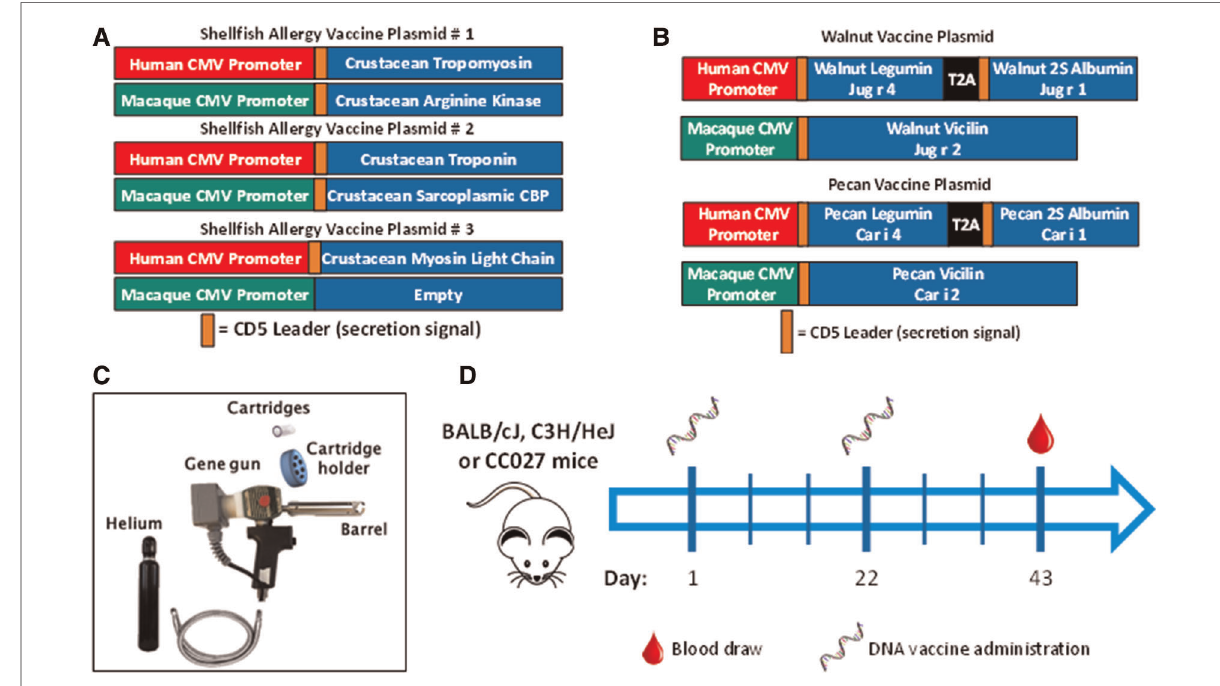
FIGURE 1 Vaccine formulation, delivery and schedule. DNA plasmid designs for ( A ) shell fi sh vaccine and ( B ) walnut/pecan vaccine. ( C ) Components of Gene Gun for transcutaneous vaccine administration. ( D ) Experimental scheme for